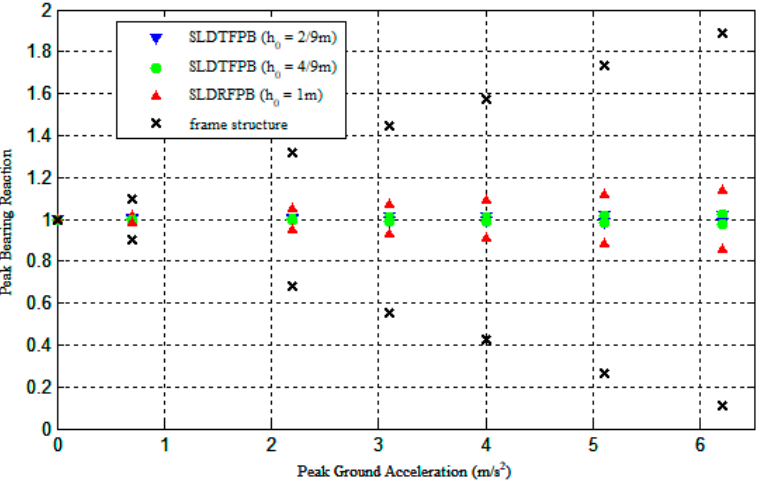
Figure 19. Peak bearing reactions of SLDRFPB and SLDTFPB.